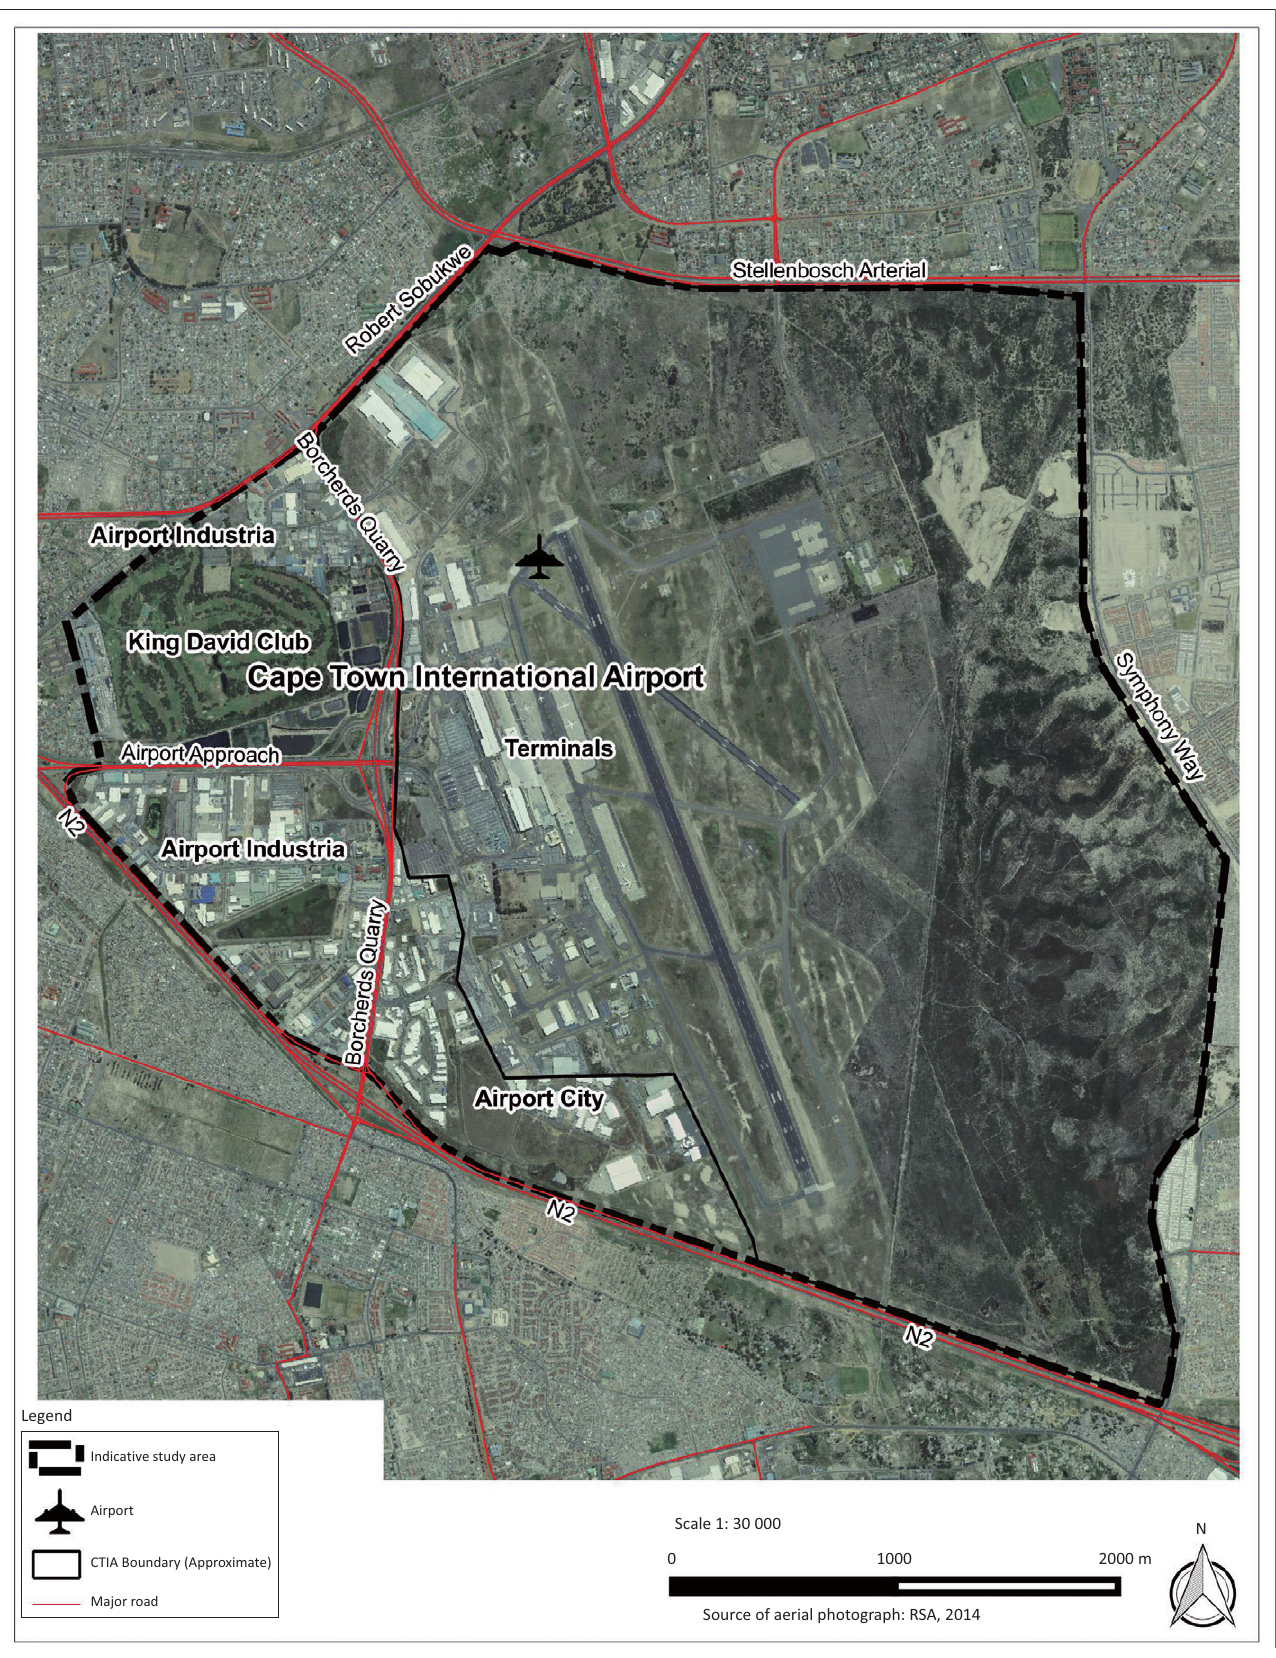
FIGURE 2: Cape Town airport-centric development.